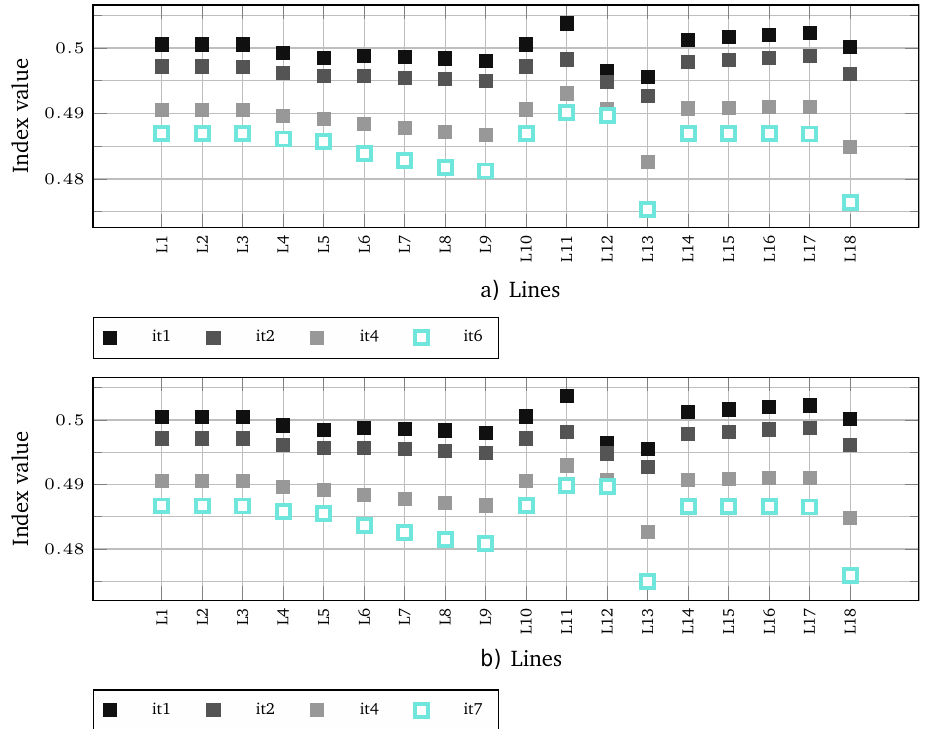
Figure 11. VCPI_1 Index for load case 2. ( a ) Constant load model. ( b ) Frequency-dependent load model.